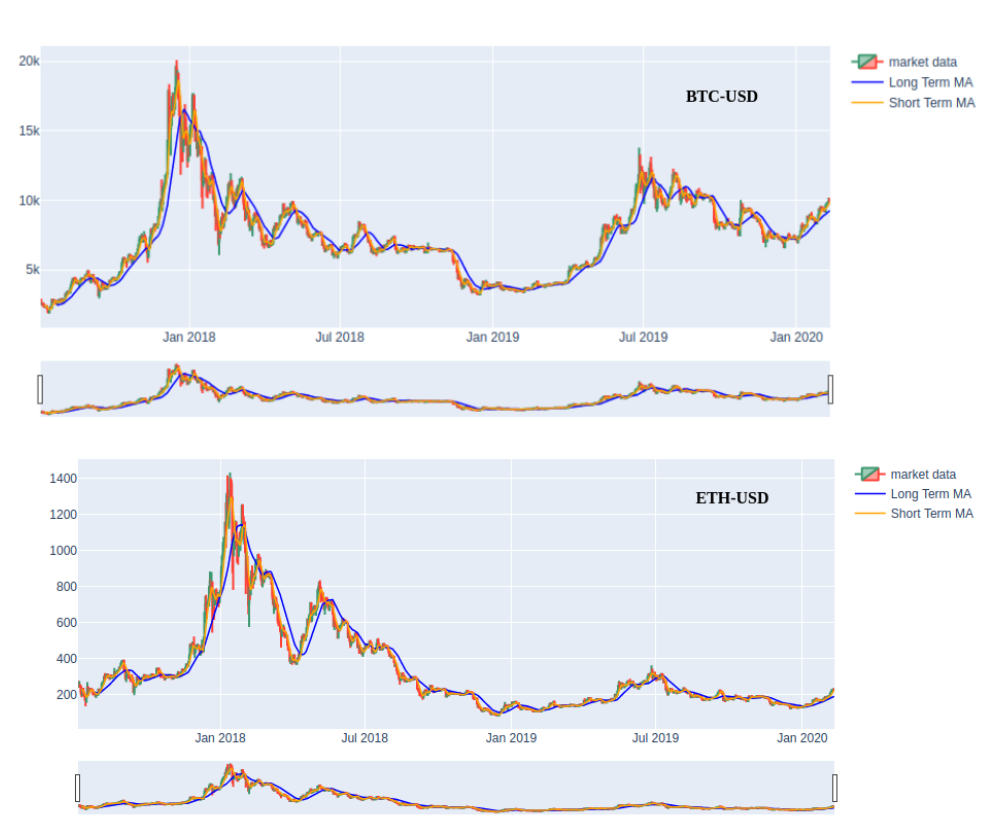
Figure 2. Bitcoin (upper) and Ether (lower) time